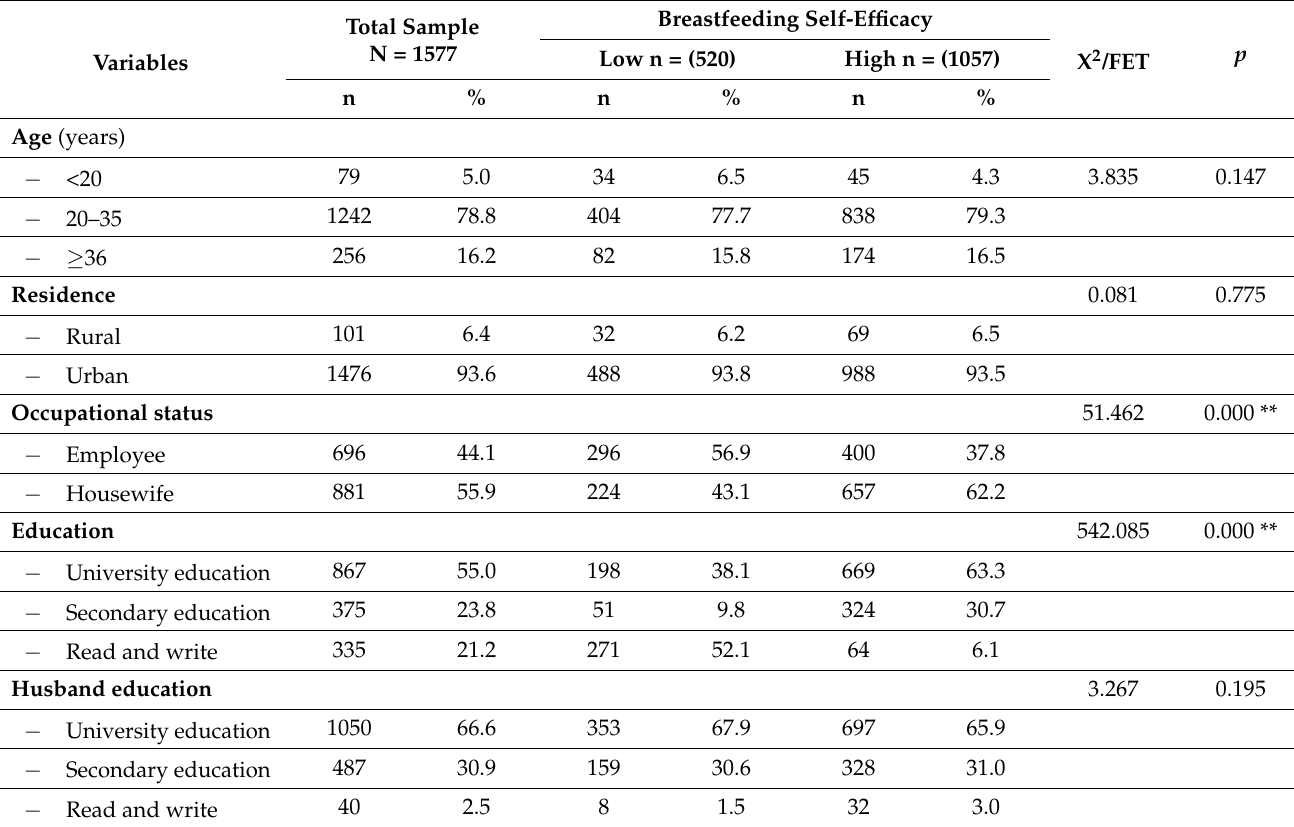
Table 1. Frequency distribution of the nursing mothers by demographic characteristics and overall breastfeeding self-efficacy